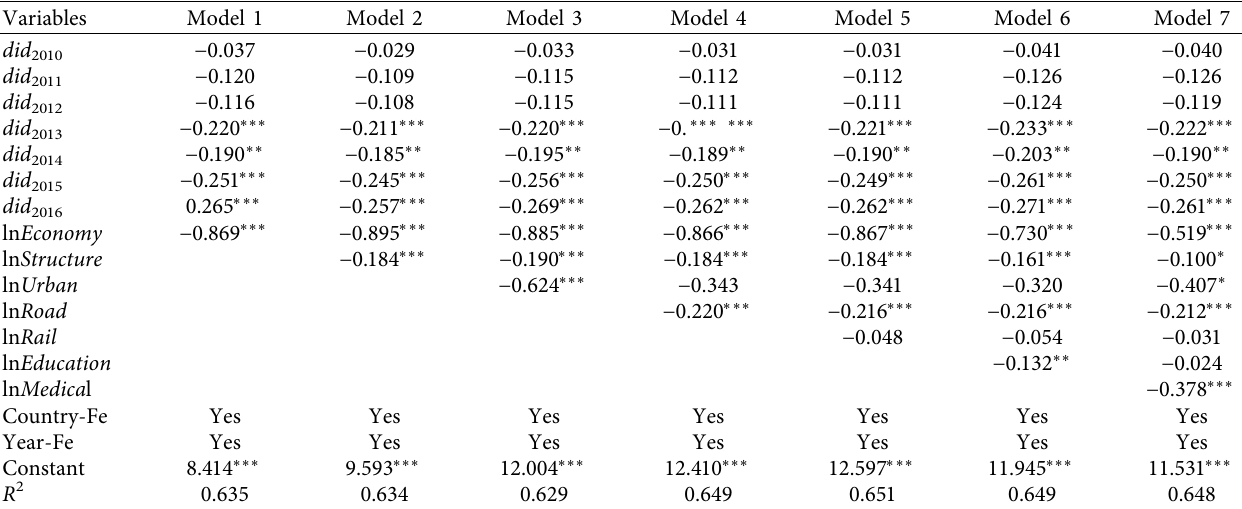
Table 4: Parallel trend test